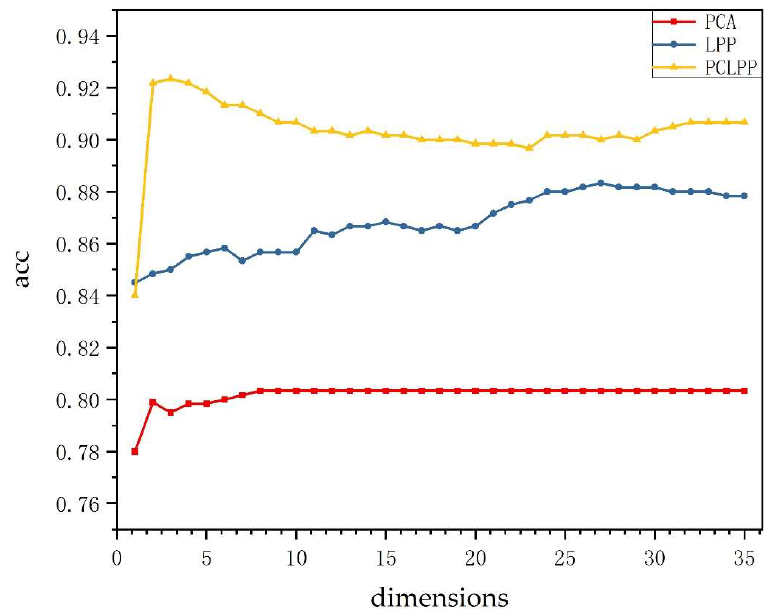
Figure 4. Finger vein recognition rates for PCA, LPP, and PCLPP in different dimensions.